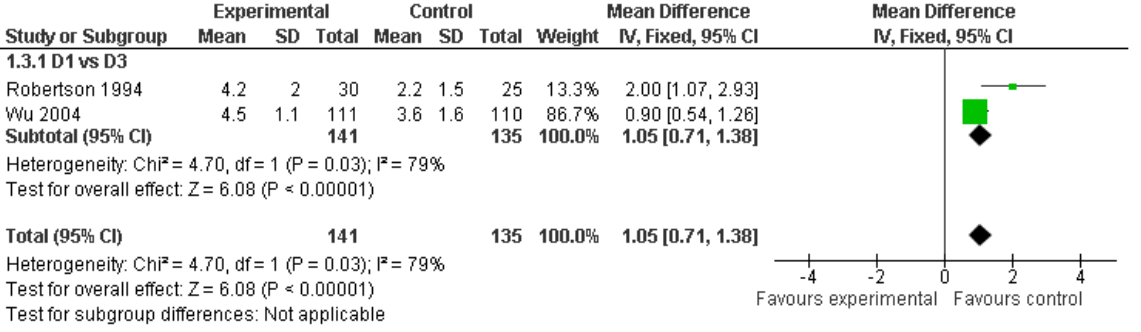
FIGURE 3 – Meta-analysis of operating time (hours). Effects estimates (odds ratio; 95% CI). Pooled treatment effect is shown as a diamond that spans the 95% CI. Significant statistical heterogeneity between studies results. Overall effect